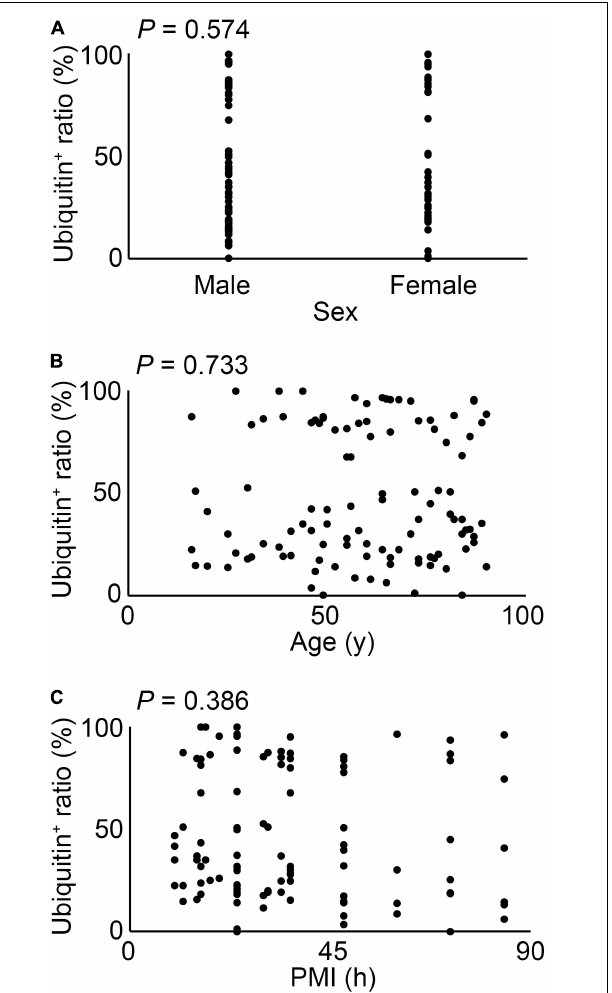
FIGURE 3 | The relation between sex (A) , age (B) or postmortem intervals (PMI) (C) and ubiquitin expression in all cases. These results were obtained with Spearman’s correlation coefficient by rank